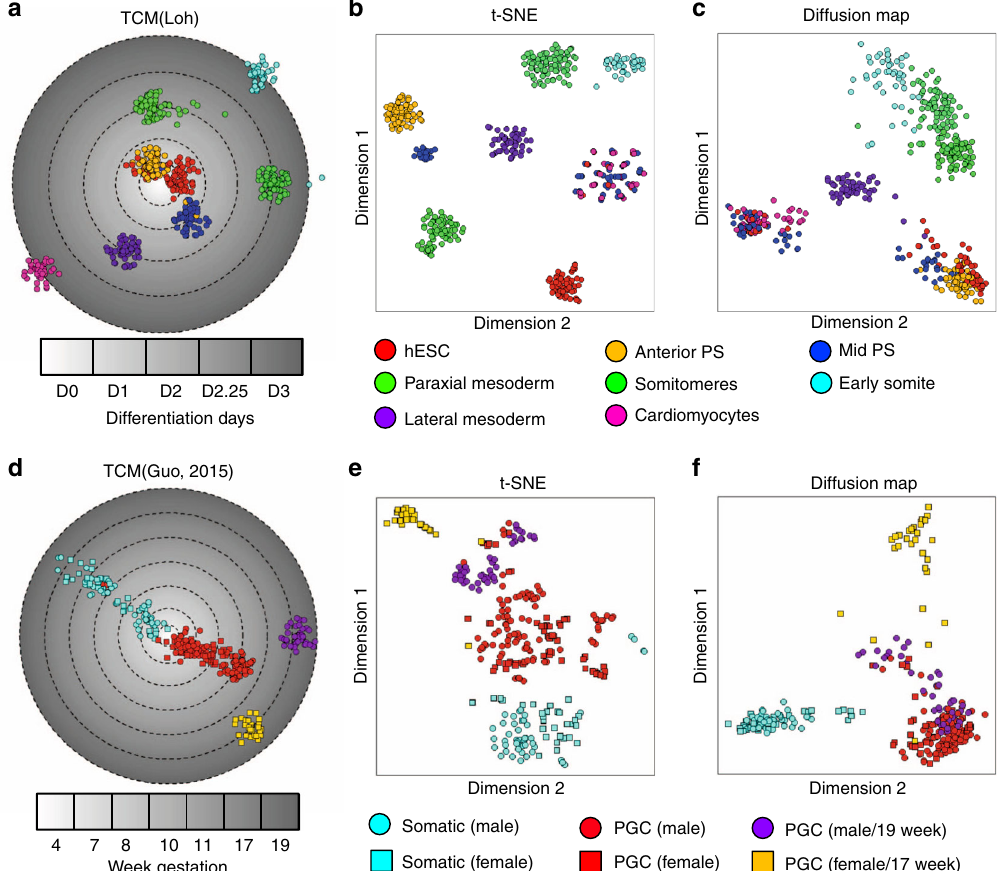
Fig. 3 TCM preserves the global developmental trajectories for the visualization of temporal single cell expression data. a-c TCM shows superior performance pertaining to the discovery of two major lineages of anterior and mid primitive streak (PS), and separating individual subpopulations compared to ( c ) t-SNE and ( d ) diffusion map on the visualization of a scRNA-seq dataset of hESC derived mesodermal lineages. d – f TCM shows superior performance compared to ( e ) t-SNE and ( f ) diffusion map on the reconstruction of the bifurcation of somatic and primordial germ cells (PGCs), and the female (17 weeks after gestation) and male (19 weeks after gestation) PGCs on a temporal scRNA-seq dataset of human somatic cell and PGC development from weeks 4 to 19 after